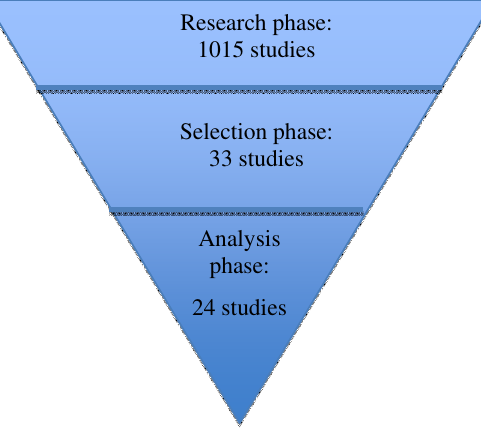
Fig. 1. Number of studies for each phase